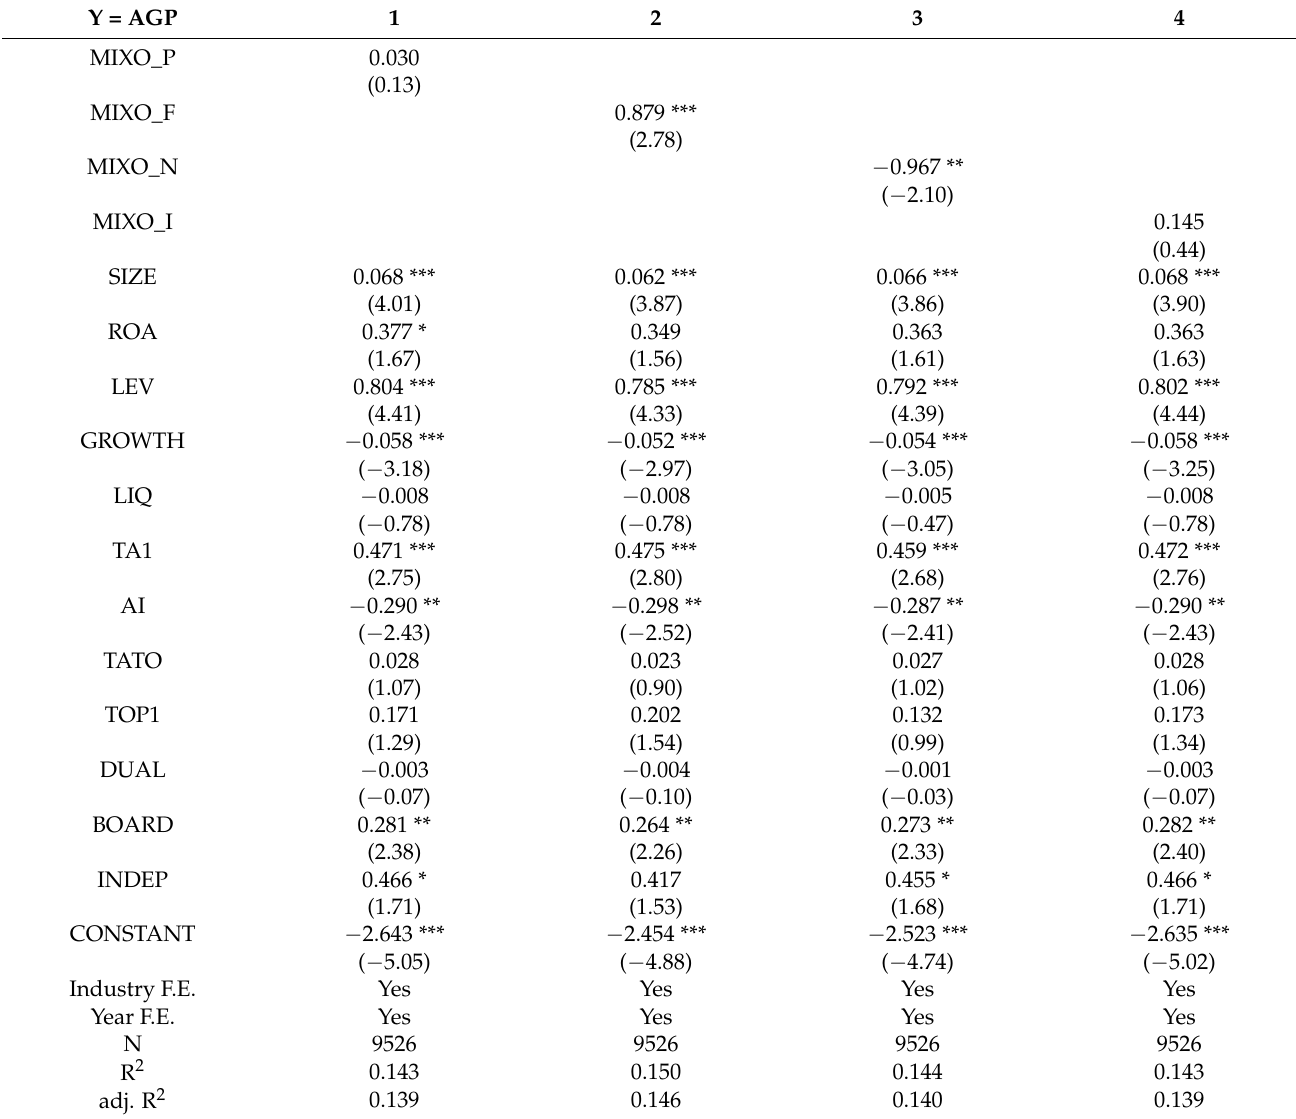
Table 4. The impact of heterogeneous shareholding ratio on the green transformation of